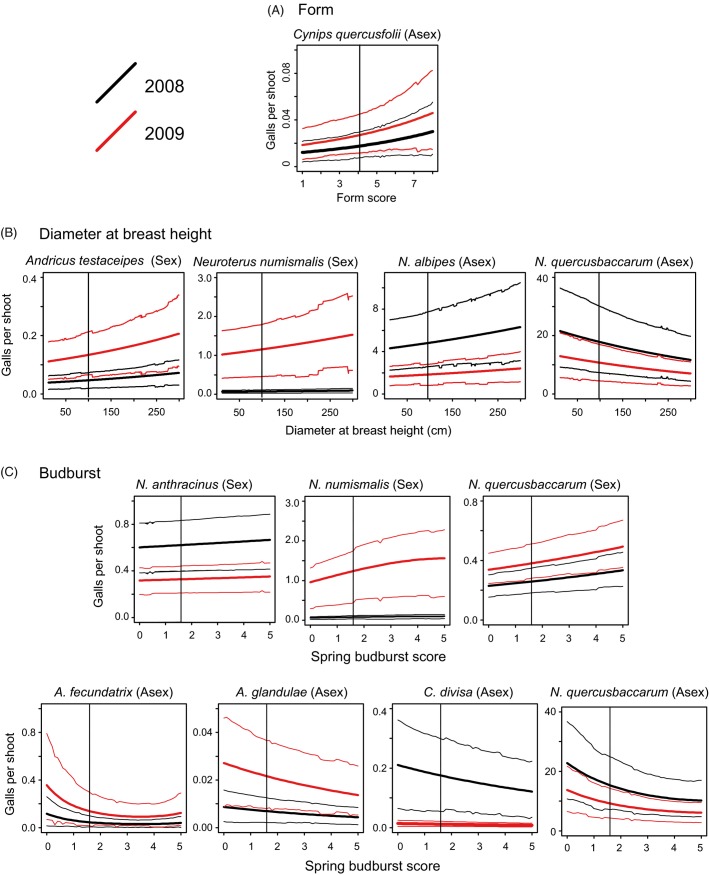
Plots of significant relationships between gall abundance and (A) Form, (B) Diameter at breast height (DBH) and (C) Budburst. Higher Form scores indicate healthier trees, while higher Budburst scores indicate earlier budburst. Distributions of y at intervals across the range of a phenotypic predictor (x) were derived from the 1000 stored Markov Chain Monte Carlo (MCMC) samples as: yi = exp(intercepti + x(mean coefficienti) + 0.5x ∑ random effect variancesi). Plots show the means (bold lines) and 95% confidence intervals from these distributions for each of the two study years. Dotted vertical lines indicate the mean value of the phenotypic trait for the most local tree provenance (Forêt de Bercé). Plots for models of the asexual generation galls of Neuroterus numismalis could not be produced in this way due to high random effect variances.